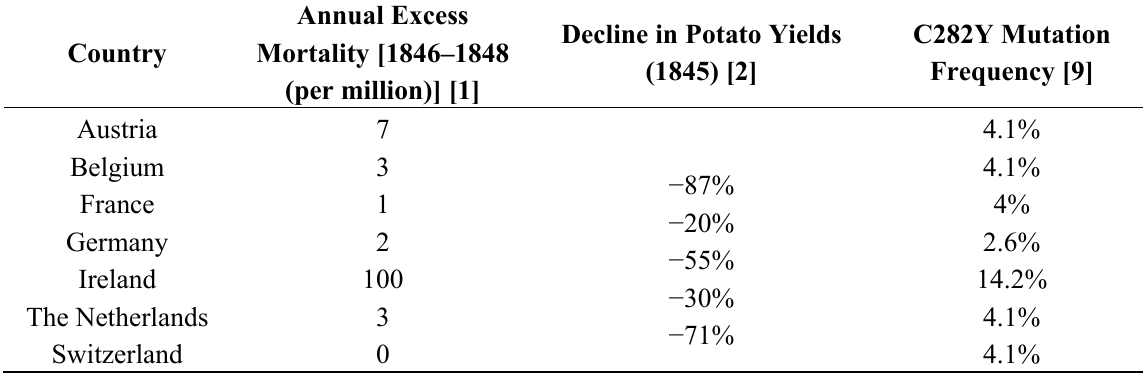
Table 1. Overview of annual excess mortality, decline in potato yields and C282Y mutation frequency in various European